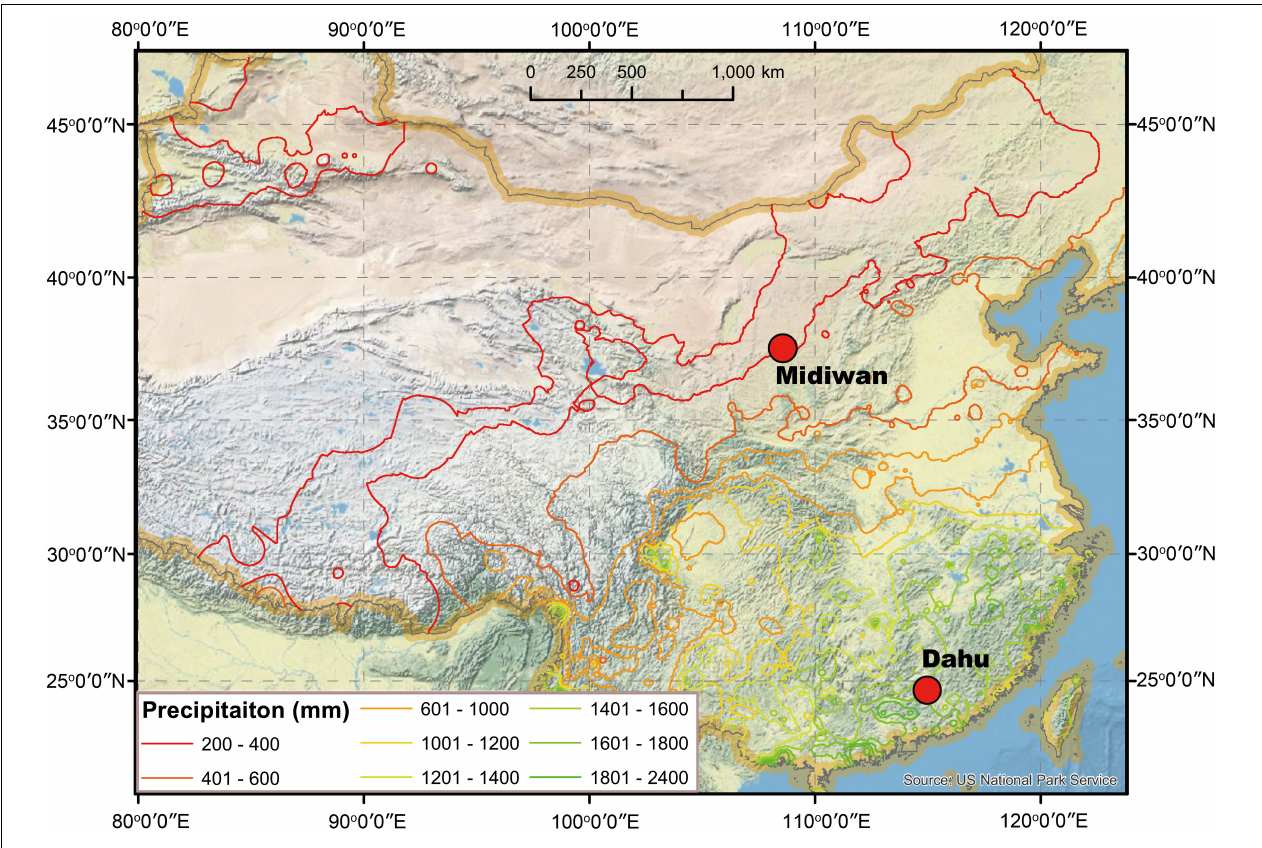
FIGURE 2 | Locations of the two peatlands used in this study. Lines in different colors show the isolines of annual